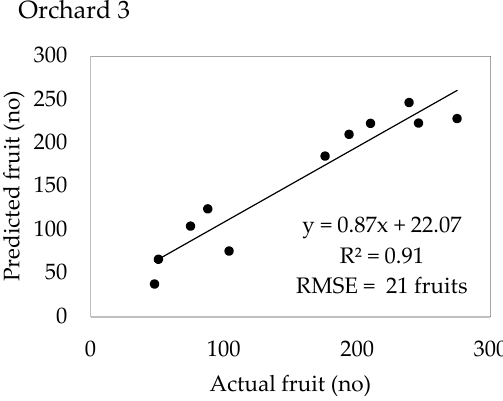
Figure 8. The correlation between actual and ANN model predicted total fruit number with combined VIs and TCA data for test set (n=11) in Orchard 1, Orchard 2 and Orchard 3.